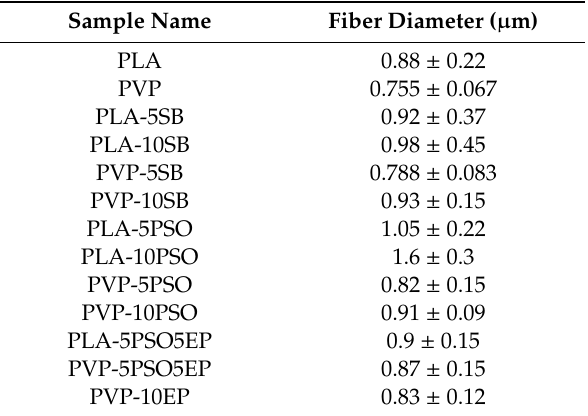
Table 2. Diameters of the